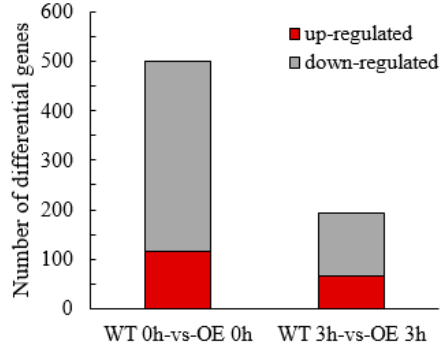
Figure 5. Di ff erential gene distribution Figure 5. Differential gene distribution map.